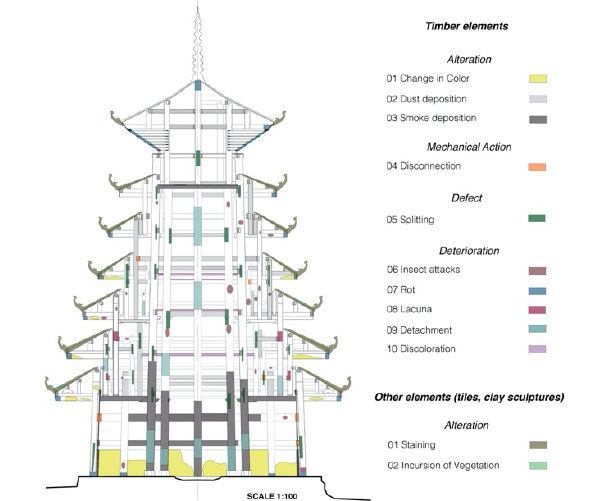
Figure 12 . Distribution of damge in representative section of Zengying Drum